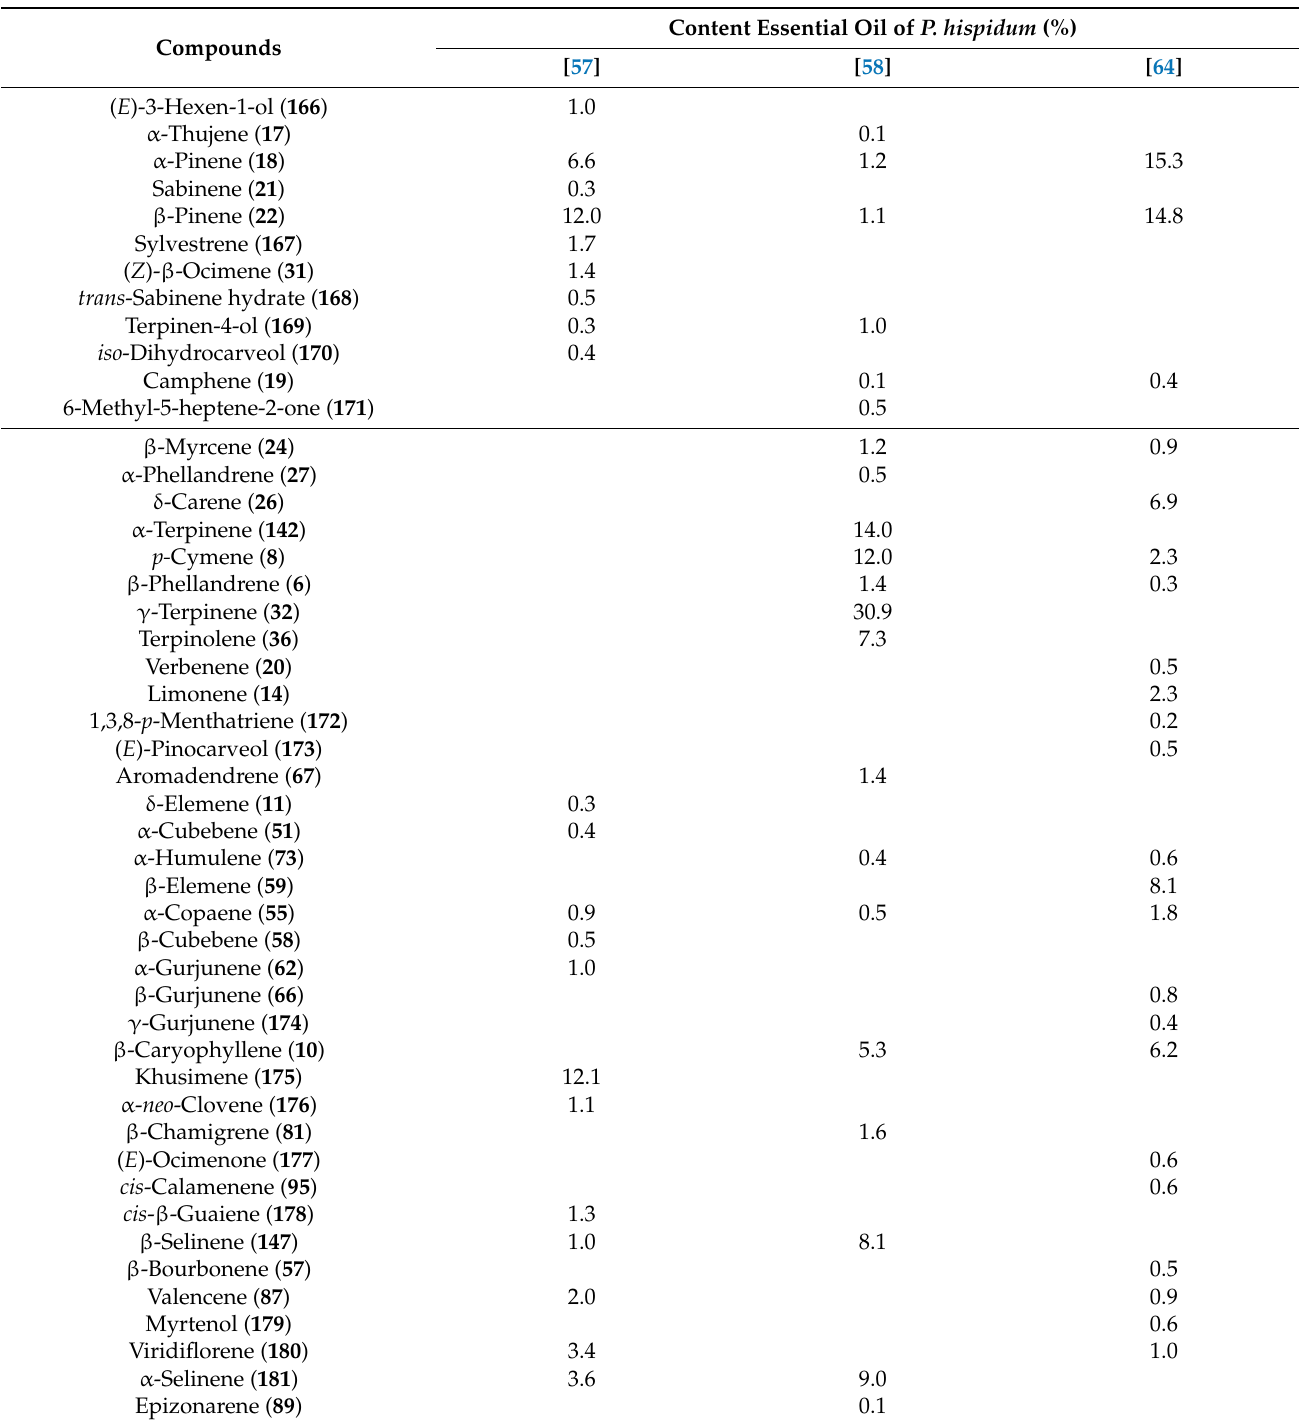
Table 4. Chemical composition of the essential oils of P. hispidum